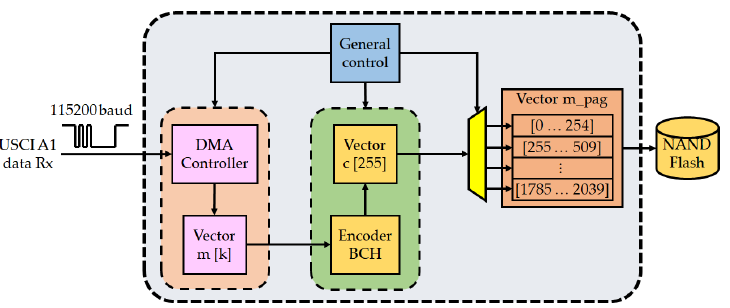
Figure 10. Data writing block diagram. The information is received via serial and stored in the vector m of the DMA module. In parallel, the information is encoded, and the NAND flash memory chip is